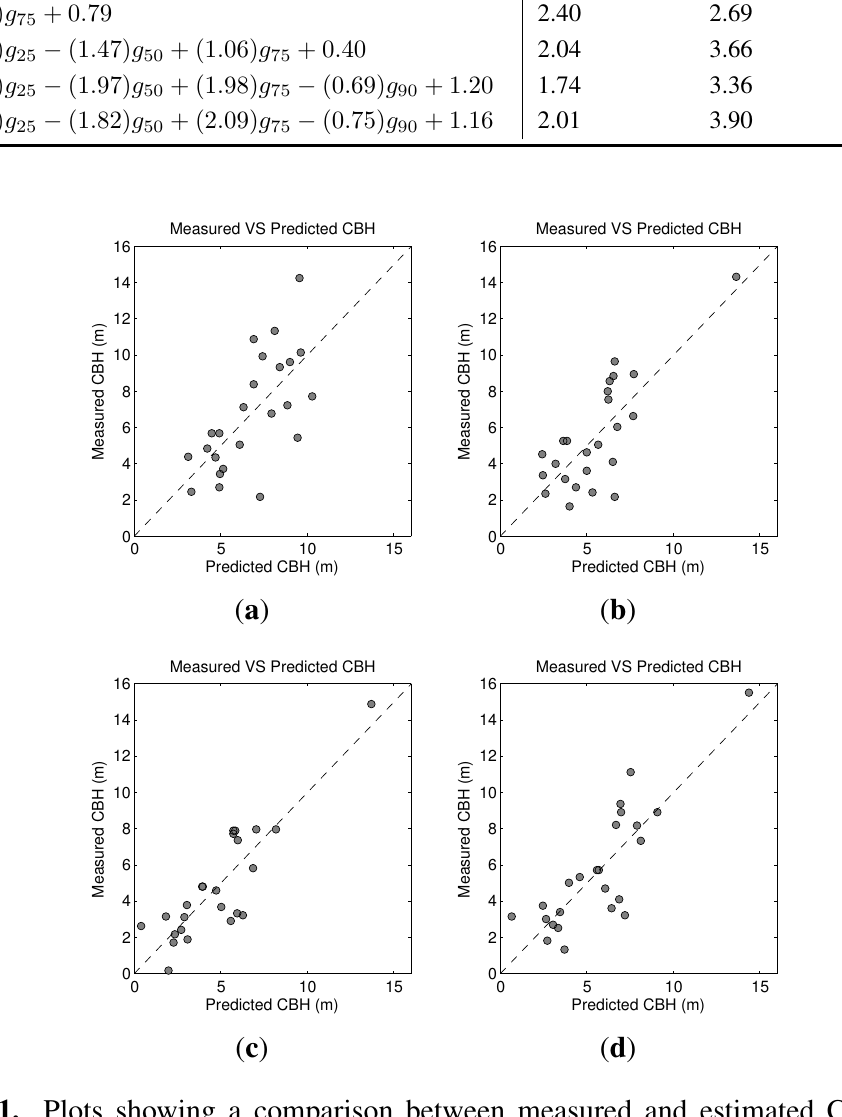
Figure 11. Plots showing a comparison between measured and estimated CBH for the proposed LiDAR metrics: ( a ) LOR; ( b ) AVG; ( c ) P40; ( d ) P50. The diagonal line shows a 1:1 relationship. Table 3. Regression models obtained using different dependent variables against traditional percentile LiDAR